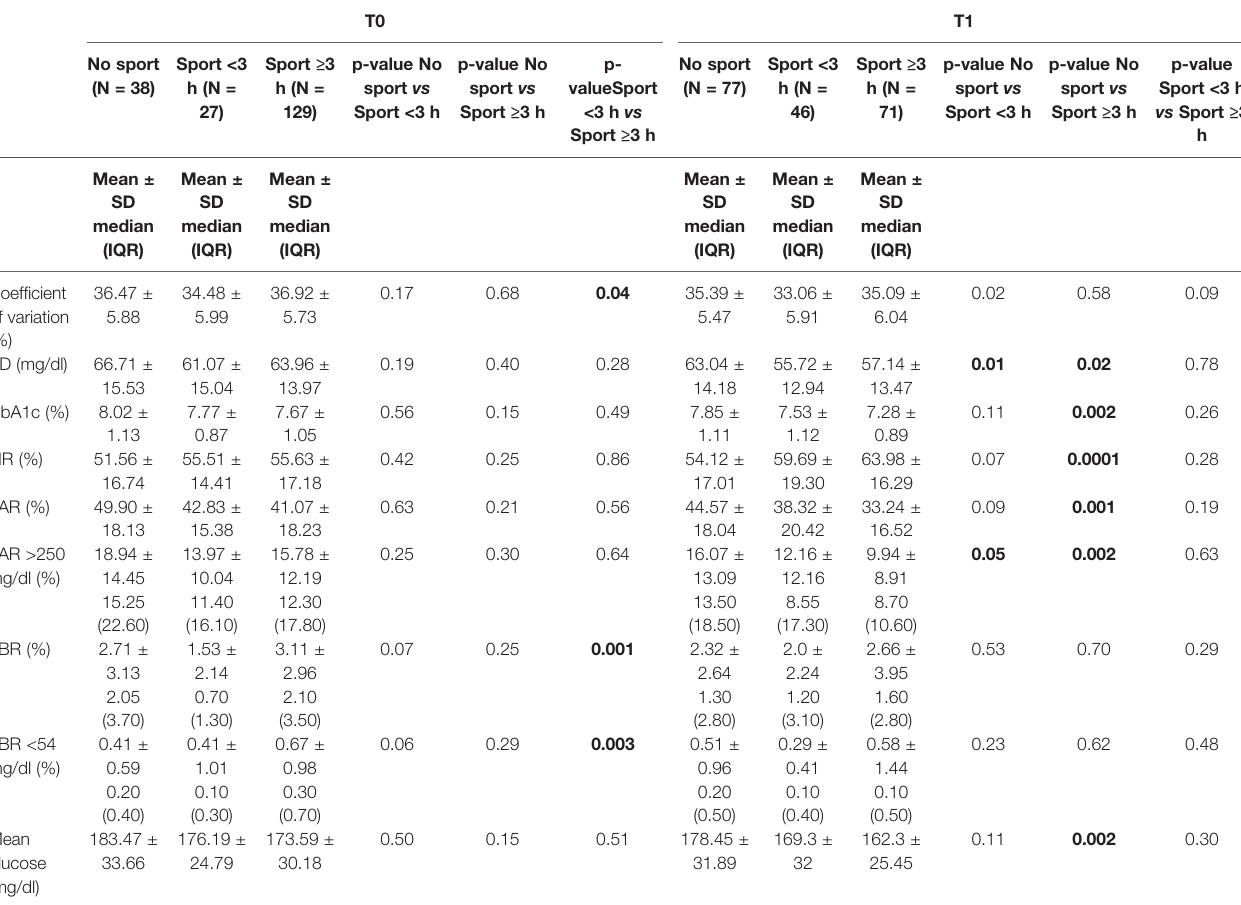
TABLE 5 | Secondary outcome: Glycemic control in relation to physical activity at T0 and T1 (N = 194). T0 T1 No sport Sport <3 (N = 38) h (N =